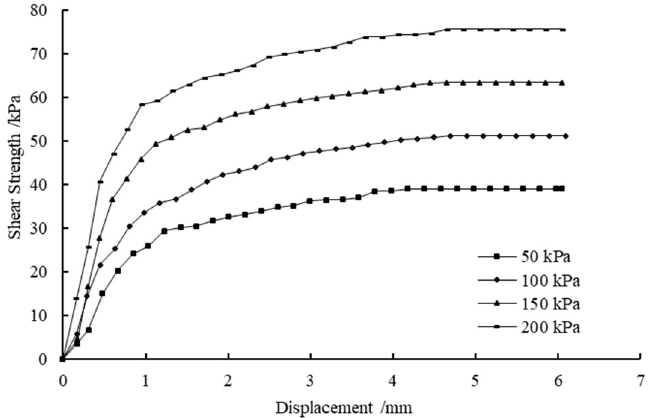
Figure 8. The stress–displacement curve of the soil samples treated with 27.5% CaCl 2 followed by 26.5% Na 2 CO 3 solutions.